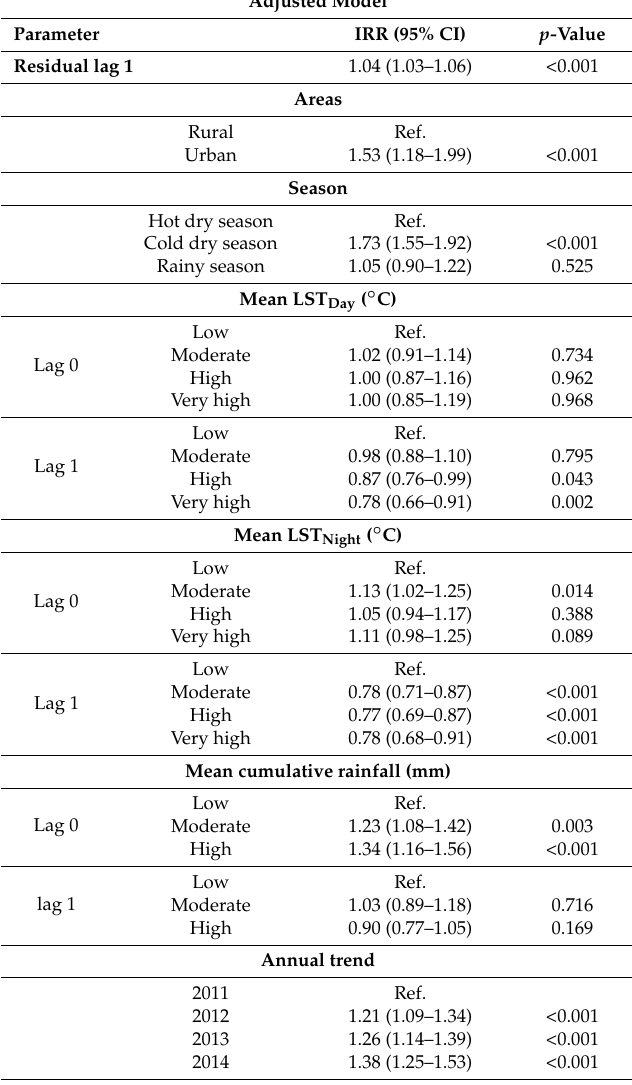
Table 6. Results from the multivariate negative binomial regression models with climatic variables of the same and the preceding month, in the health district of Mbour, Senegal (January 2011–December